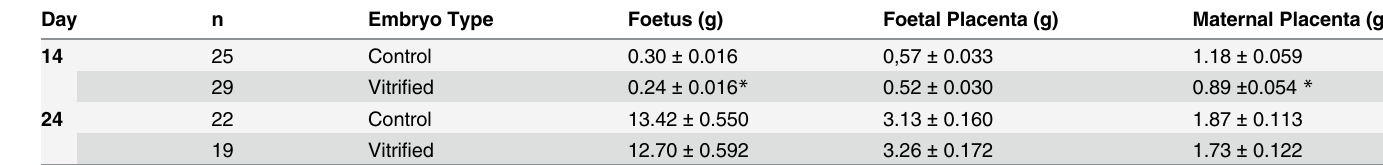
Table 1. Foetal and placental weights at Day 14 and Day 24 of